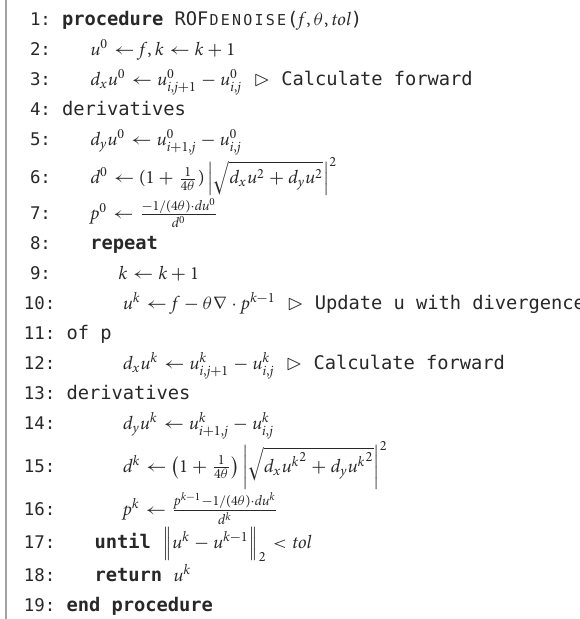
Algorithm 2. Implemented ROF denoising.